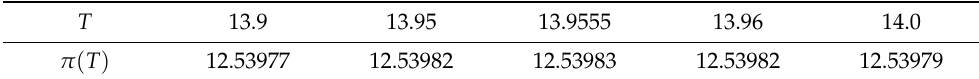
Table 6. Related profits for Example 4.